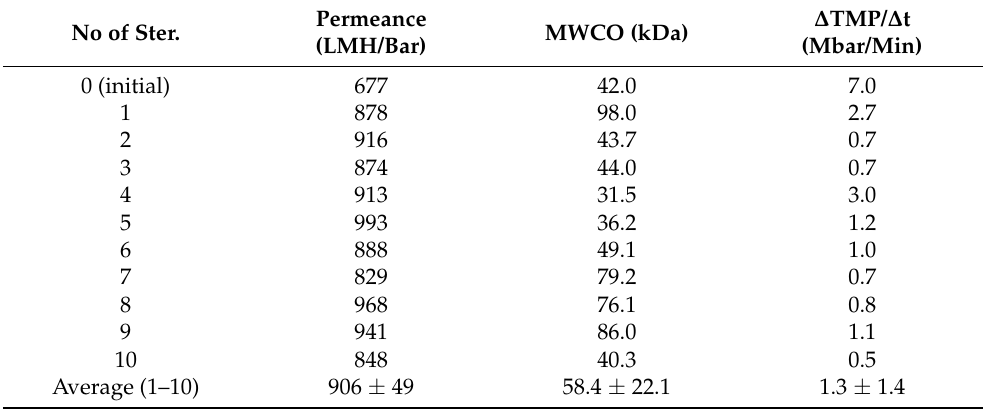
Table 4. Experimental data regarding permeance, molecular weight cut-off (MWCO), and TMP increase rate ( ∆ TMP/ ∆ t) after each cycle of sterilization. Permeance was determined from clean water flux tests. MWCO and TMP increase rate were estimated from the dextran rejection tests. No of Ster.